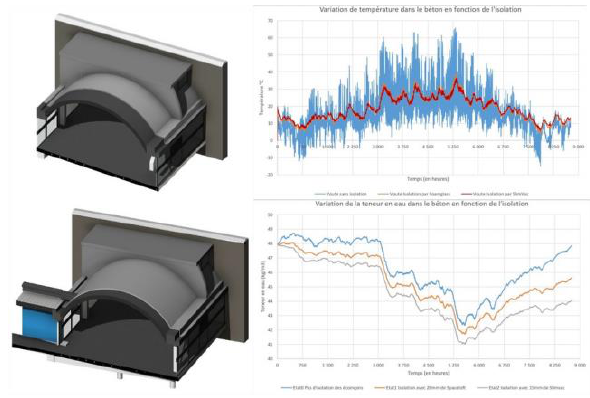
Figure 7. On-site measurement results